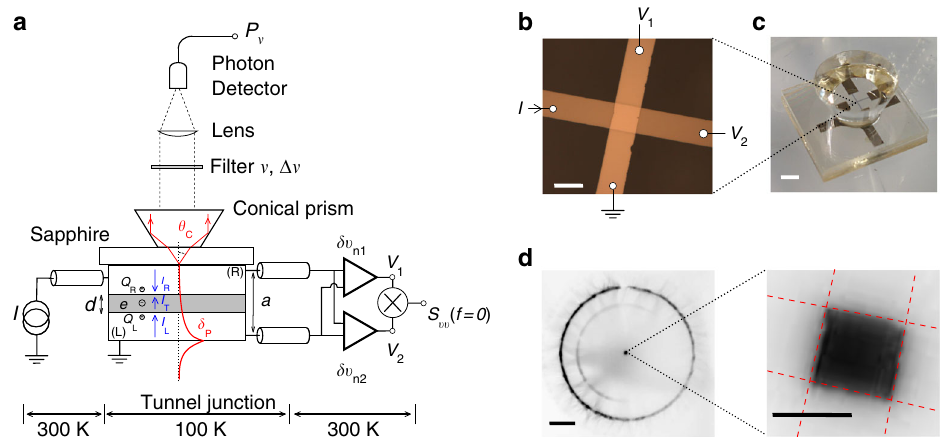
Fig. 3 Experimental setup. a Schematic of the experimental setup. The blue arrows indicate the conventional direction of the current. The red curve corresponds to the amplitude of the electric fi eld of the SPP mode. The red arrows depict the propagating rays in the Kretschmann con fi guration. b Optical micrograph of the metallic cross-junction. Scale bar: 100 μ m. c Optical picture of the Kretschmann con fi guration used to couple the surface plasmon polariton localized at the interface electrode/vacuum to the radiating fi eld. The conical prism enables to collect photons via a total internal re fl ection. Scale bar: 1 mm. d Emitted light from the tunnel junction ( I = 1.7 mA) directly observed with a sensitive camera in the spectral range 0.4 – 1 μ m. Scale bars: 1 mm (left) and 100 μ m (zoom, polarization charge e (1 − z / d ) and ez / d in the left and right